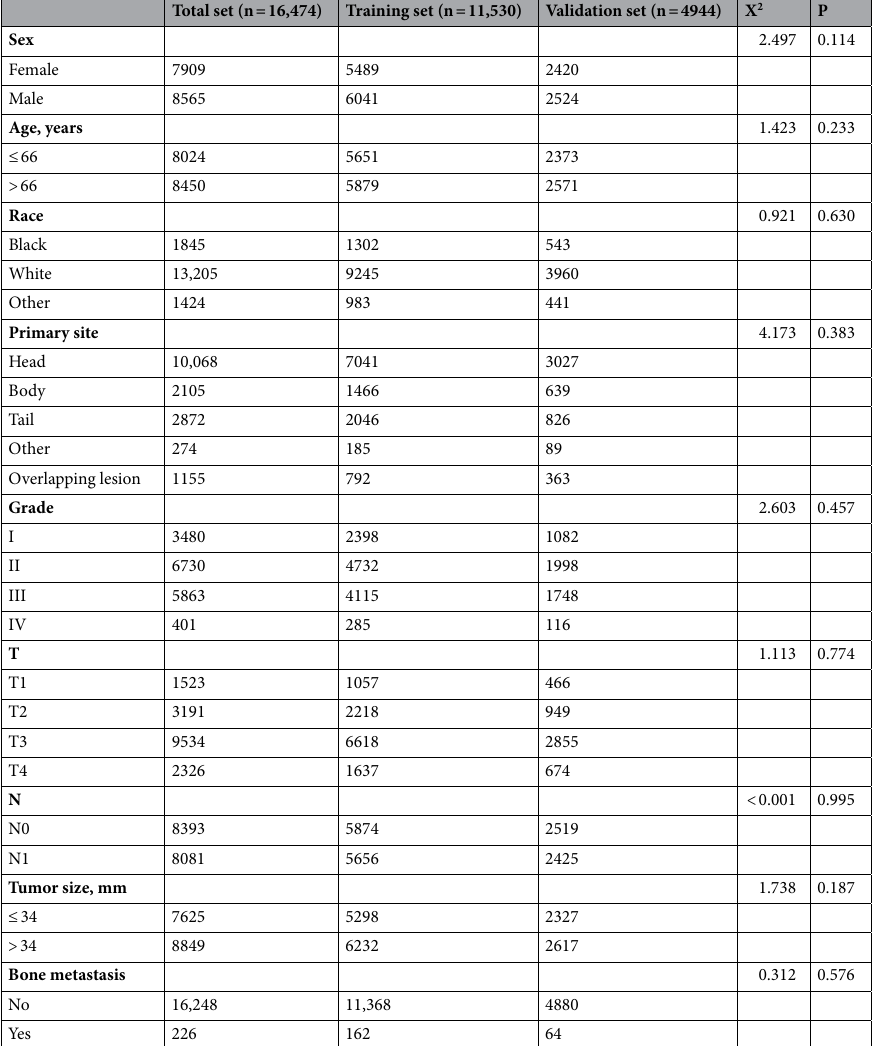
Table 1. Clinical characteristics of 16,474 pancreatic cancer